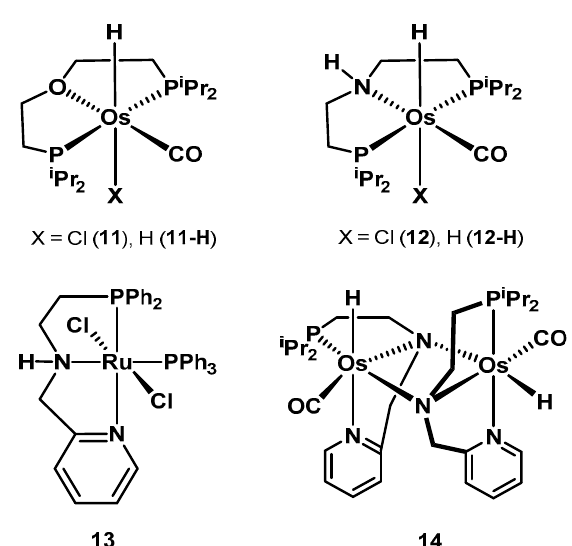
Figure 1. Representative examples of ruthenium and osmium pincer catalysts reported by Gusev [73,178,179].